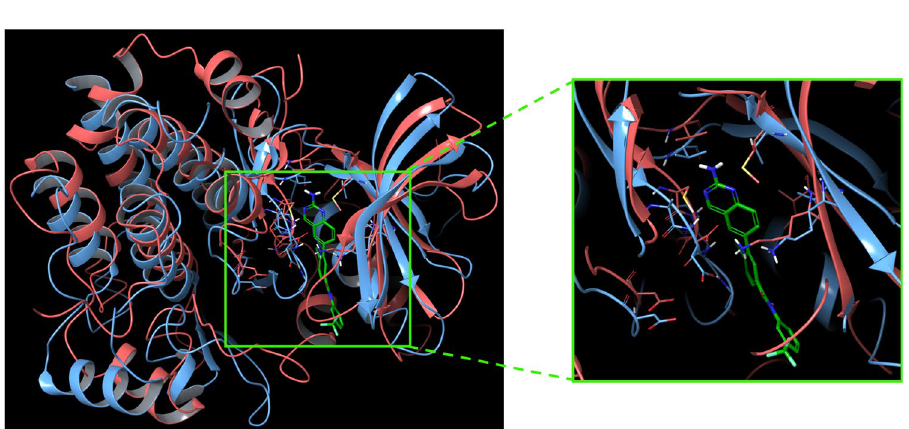
Figure 7. Superposition of pocket amino acids belonging to similar kinases. On the left, superposition of binding site amino acids from the original MAP2K1 target (UniProt ID: P06239, orange chain from PDB 1S9J), complexed with its ligand CHEMBL212900 (green molecule), and the potential novel target, LCK protein (UniProt ID: Q02750, cyan chain from PDB 1QPC); on the right, a close-up of the superimposed binding site